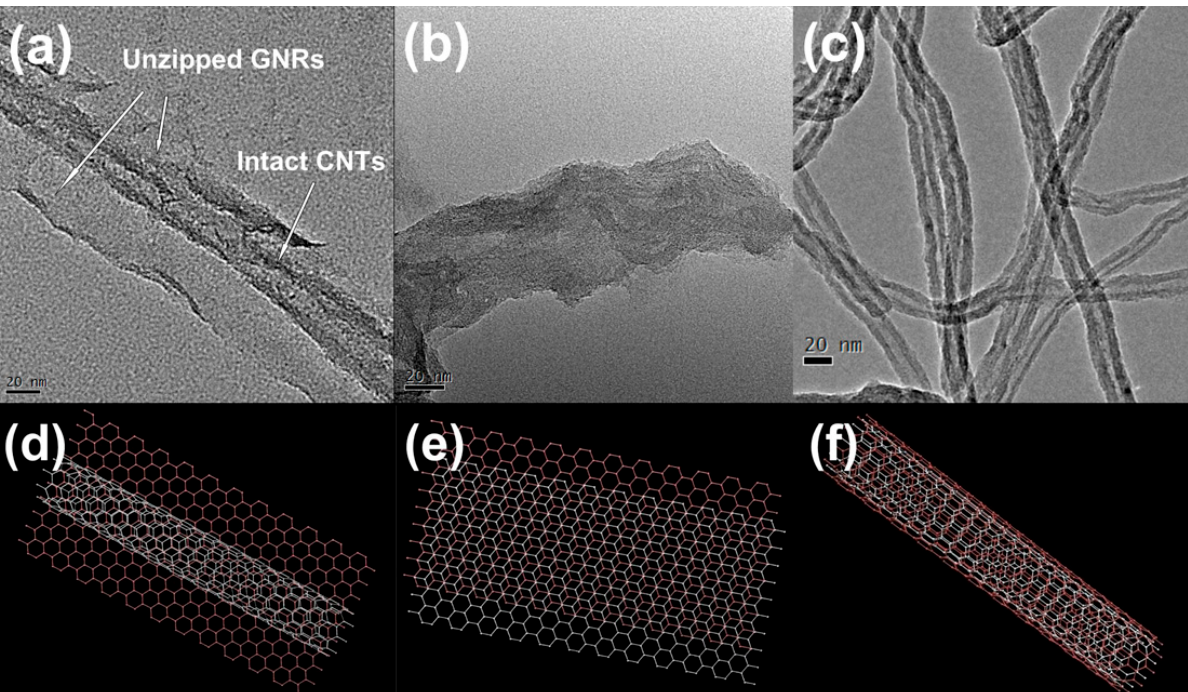
Figure 1. ( a – c ) TEM images and ( d – f ) structure diagrams of the CNT@GONRs, GONRs, and MWCNTs. X-ray photoelectron spectroscopy (XPS) was used to analyze the element species and chemi- cal attributes of the different samples. In the XPS C1s spectra of the CNT@GONRs (Figure S1a), the three peaks at 286.2, 287.1, and 288.2 eV—corresponding to C–O (epoxy/hydroxyl), C=O (carbonyl), and O–C=O (carboxyl) [31], respectively—reveal that an abundance of oxygen- containing functional groups in the form of sp 3 -hybridized saturated carbons was generated during the unzipping of the MWCNTs. The spectra were similar to GO, as reported in [7]. After reduction, as shown in the spectrum of the CNT@GNR@GA, the peak intensity of C=C (284.5 eV) rose dramatically, while that of C–O, C=O, and O–C=O decreased sharply, indicating the removal of oxygen-containing functional groups. The peak of π – π * (289.3 eV, Figure S1b) appeared, revealing the recovery of aromaticity and saturation. The sp 2